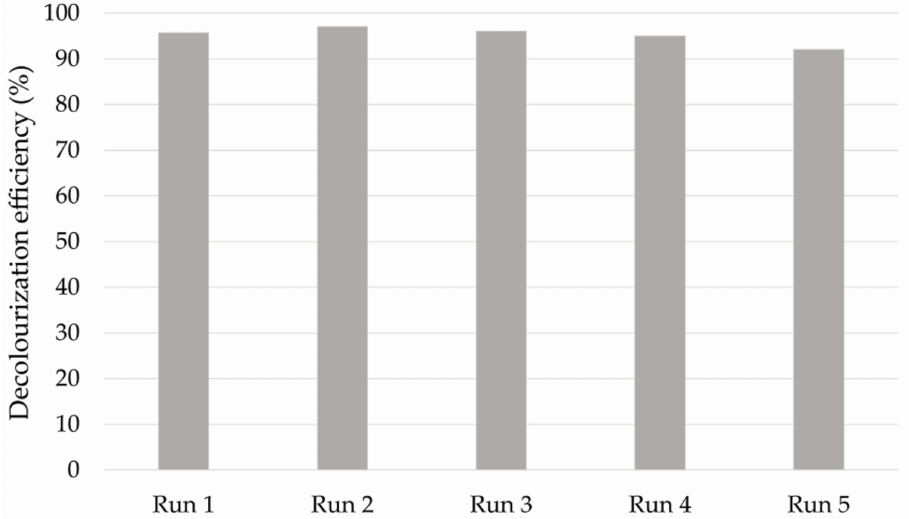
Figure 10. Repeated photodegradation under optimal